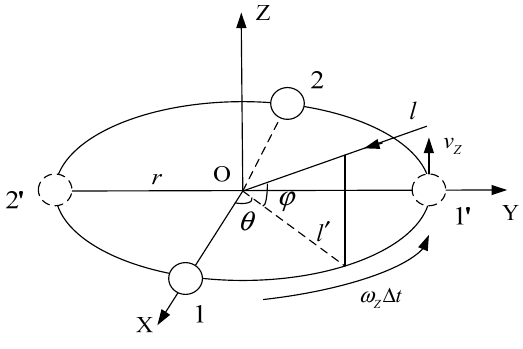
Figure 2. Rotation array structure